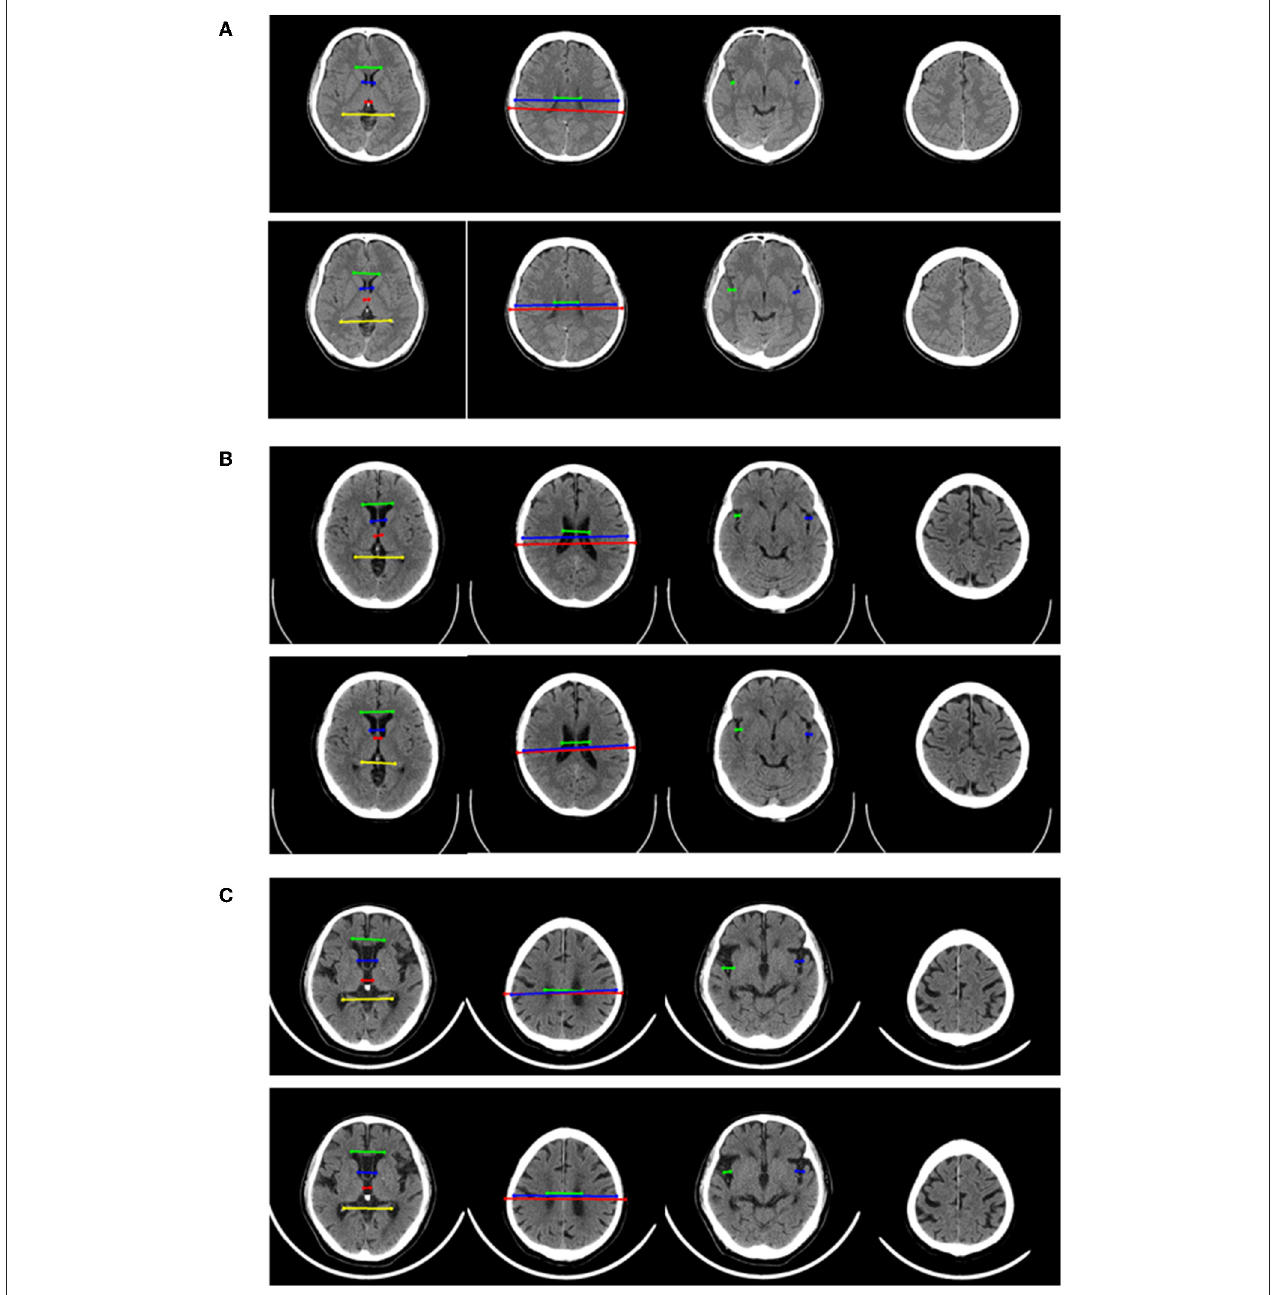
FIGURE 6 | Representative examples in no-atrophy, mild atrophy, and severe atrophy groups that were misclassified. For each example, 4 key slices were presented from manual annotation (top) and results of 2D model (bottom). On key slice 1, the green line represented A, the blue line represented B, the red line represented C and the yellow line represented D; On key slice 2, the green line represented E, the blue line represented F and the red line represented G; On key slice 3, the green line represented HL, while the blue line represented HR. (A) . Example case that was misclassified by 2D model but correctly predicted by 3D model, 2D-integrated model and 3D-integrated model in the no-atrophy group. (B) . Example case that was misclassified by 2D model, 3D model and 3D-integrated model but correctly predicted by the 2D-integrated model in mild atrophy group. (C) . Example case that was misclassified by all four models in severe atrophy